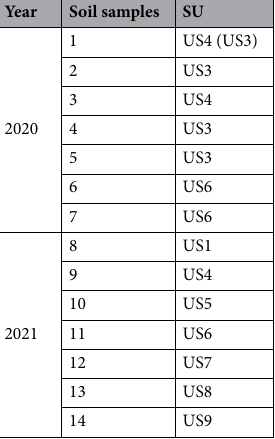
Table 1. Soil samples collected during 2020 and 2021 excavation seasons from the archaeological site of “Colombare di Negrar di Valpolicella” (SU: stratigraphic unit).